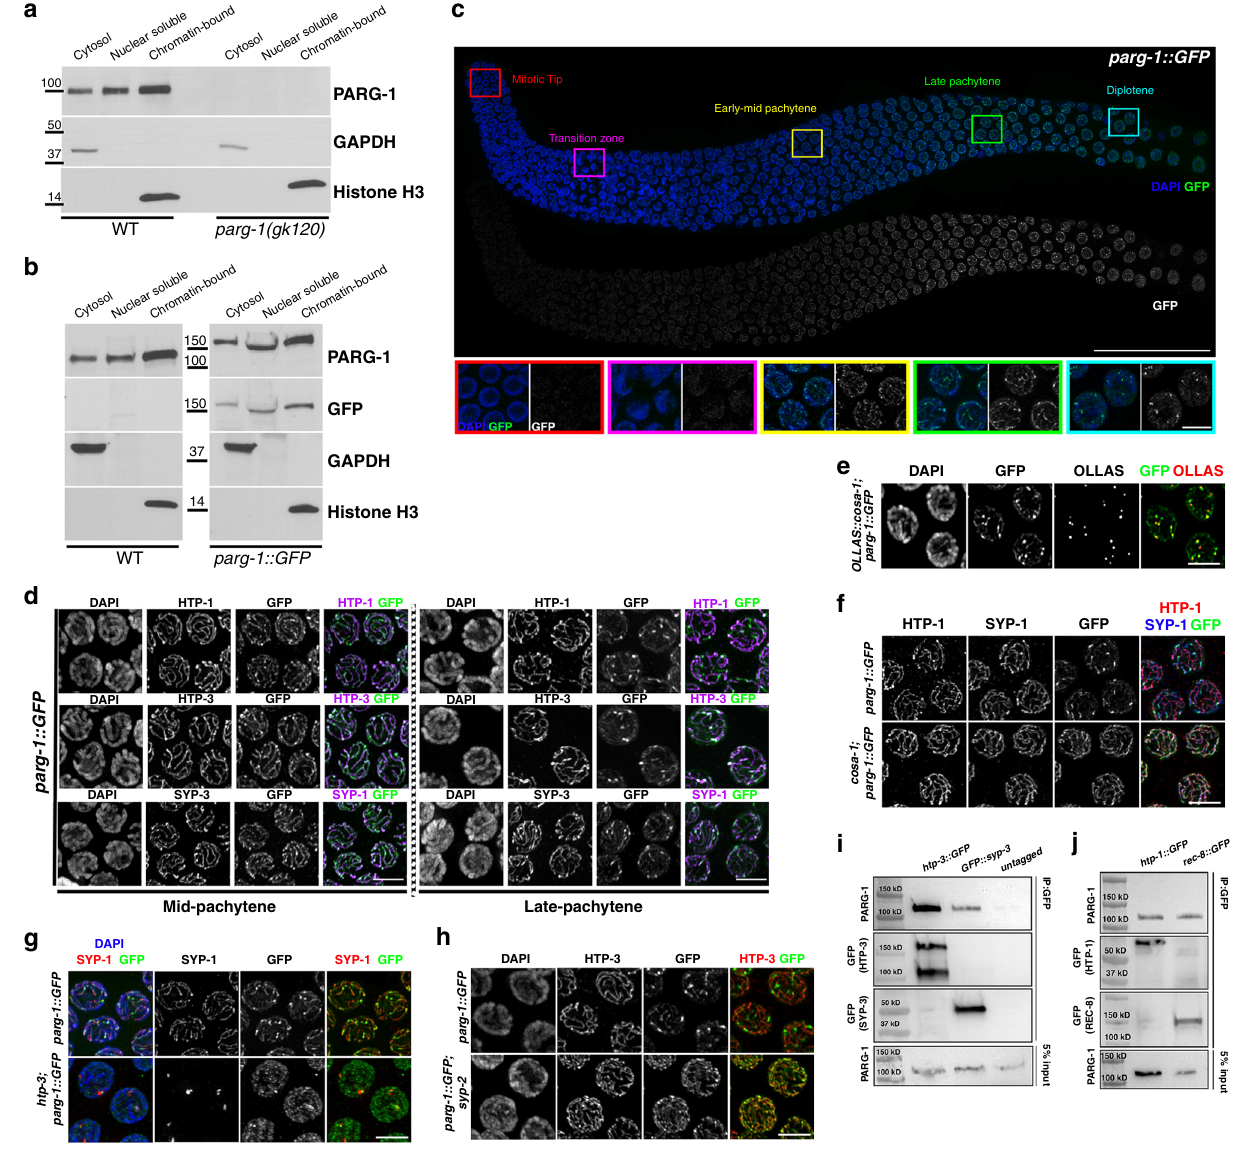
Fig. 2 PARG-1 interacts with SC components and requires chromosome axes for proper localization. a Western blot analysis of fractionated extracts detects PARG-1 in all subcellular compartments with enrichment in the nuclear chromatin-bound fraction. GAPDH was used as a loading control of the cytosolic fraction and Histone H3 for the chromatin-bound fraction. Analysis was performed in biological duplicates. b Western blot analysis of fractionated extracts showing similar expression of GFP-tagged and untagged PARG-1. Analysis was performed in biological duplicates. c Top: PARG-1::GFP localization in a wild-type gonad. Scale bar 30 μ m. Bottom: enlarged insets showing dynamic localization of PARG-1::GFP in different stages of meiotic prophase I. Scale bar 5 μ m. Analysis was performed in biological triplicates. d Mid- and late-pachytene nuclei of parg-1::GFP co-stained for lateral (HTP-1 and -3) and central component (SYP-1) of the SC. Scale bar 5 μ m. Analysis was performed in biological triplicates. e Late pachytene nuclei showing overlapping localization of PARG-1::GFP with OLLAS::COSA-1. Scale bar 5 μ m. Analysis was performed in biological triplicates. f Late pachytene nuclei stained for HTP-1, SYP-1, and GFP showing localization of PARG-1 along chromosomes. In cosa-1 mutants, redistribution of PARG-1::GFP to the short arm of the bivalent is absent. Scale bar 5 μ m. Analysis was performed in biological triplicates. g Impaired axes formation in htp-3 mutants prevents PARG-1::GFP localization. Arrow heads indicate regions of DNA devoid of PARG-1::GFP. Scale bar 5 μ m. Analysis was performed in biological triplicates. h PARG-1::GFP associates with HTP-3 in late-pachytene nuclei in absence of synapsis. Scale bar 5 μ m. Analysis was performed in biological duplicates. i Western blot analysis of endogenous PARG-1 on GFP pull downs performed in htp-3::GFP and GFP::syp-3 strains. Wild-type worms were used as the untagged negative control. Analysis was performed in biological duplicates. j Western blot analysis of endogenous PARG-1 on GFP pull downs performed in htp-1::GFP and rec-8:: GFP strains. Analysis was performed in biological PARG-1::GFP was detectable mostly in the nucleoplasm (Sup- plementary Fig. 1C). Co-staining with axial proteins HTP-1/ HTP-3 and the central SC component SYP-1 38,39,48 revealed recruitment of PARG-1::GFP onto synapsed chromosomes and con fi rmed its retraction to the short arm of the bivalent in late